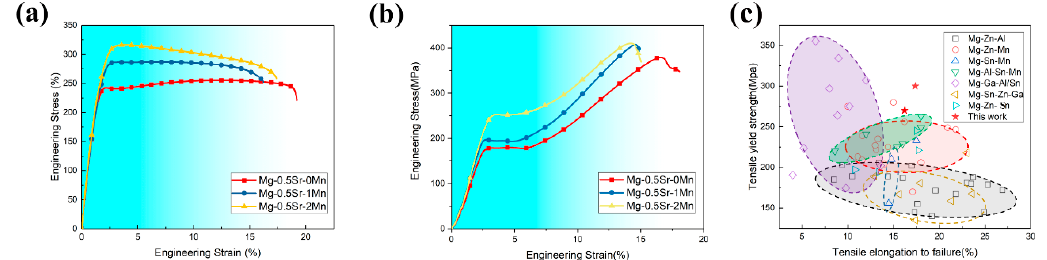
Figure 6. Effect of Mn on mechanical properties of as-extruded Mg-0.5Sr-xMn alloys in tensile testing along the extrusion (x = 0, 1, and 2 wt.%). ( a ) Engineering tensile stress-strain curves; ( b ) Engineering compression stress-strain curves; ( c ) Comparison of tensile yield strength (TYS) vs. strain for Mg-XMn-0.5Sr alloys with some common low-cost alloys [27–36].